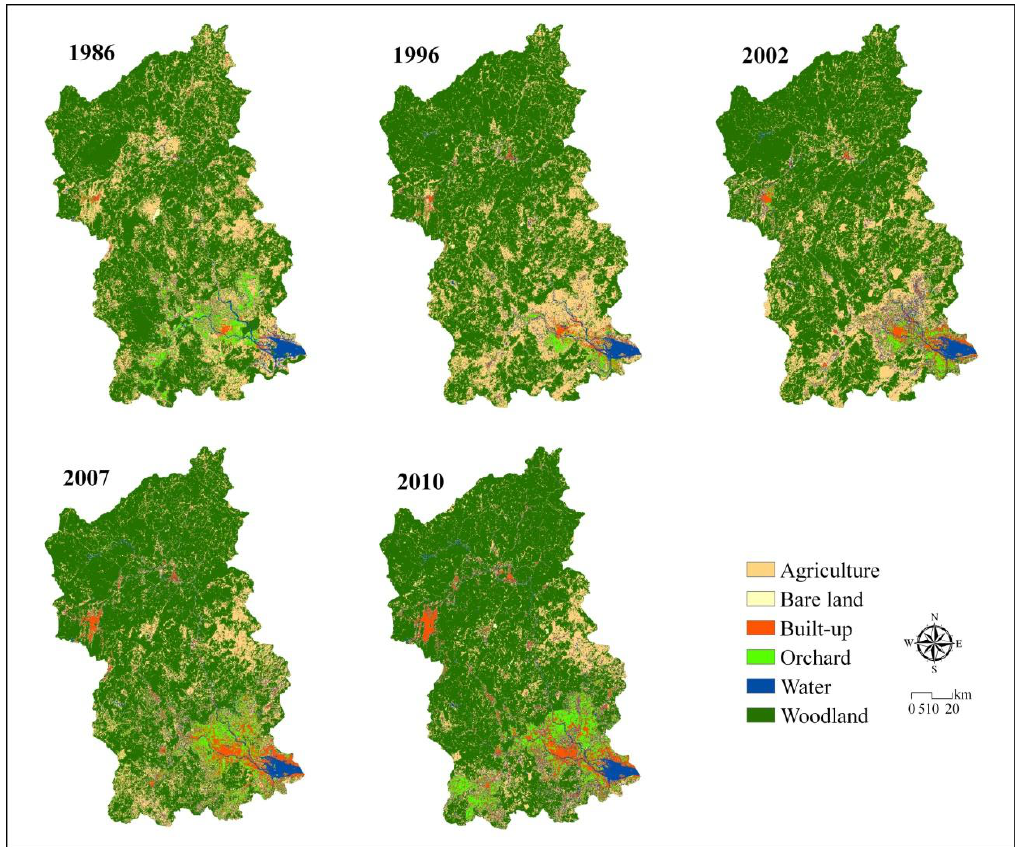
Figure 6. LULC maps of the JRW in 1986, 1996, 2002, 2007 and 2010.